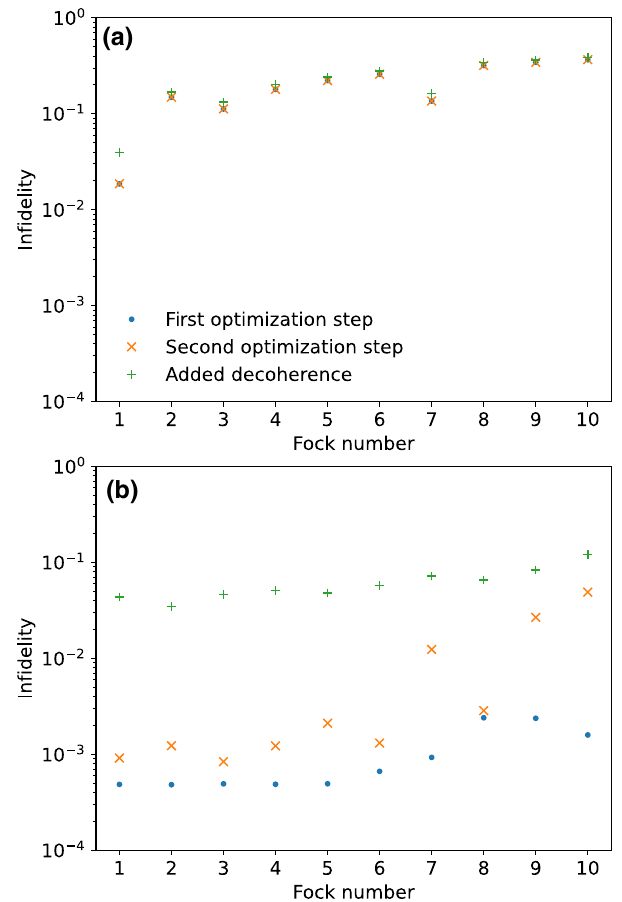
FIG. 8. Simulated infidelity of Fock states prepared using (a) one and (b) two SNAP